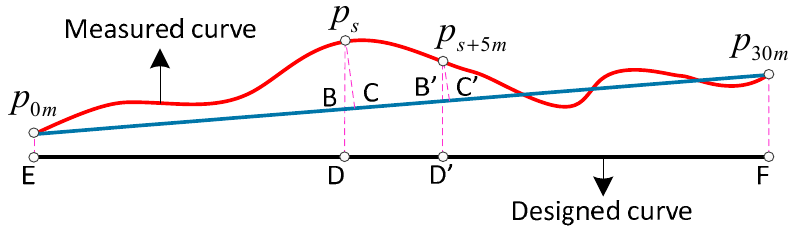
(cid:114) (cid:16) (cid:16) (cid:17) 2 (cid:16) (cid:17) 2 (cid:17) 2 − r n 0 + − r n 0 + − r n 0 r n 0 r n 0 r n 0 where l c = represents the length of the p 30 m N p 0 m N p 30 m E p 0 m E p 30 m D p 0 m D chord. l 5 m = 5 m is the distance between points p s and p s + 5 m . The derivation processes of Equations (18) and (19) are shown in Appendix A. As Figure 7 illustrates, even though the absolute position measurements may have deviations bigger than centimeter scale, the relative deviations can also be millimeter scale due to the common offset contained by the adjacent points p s and p s + 5 m .